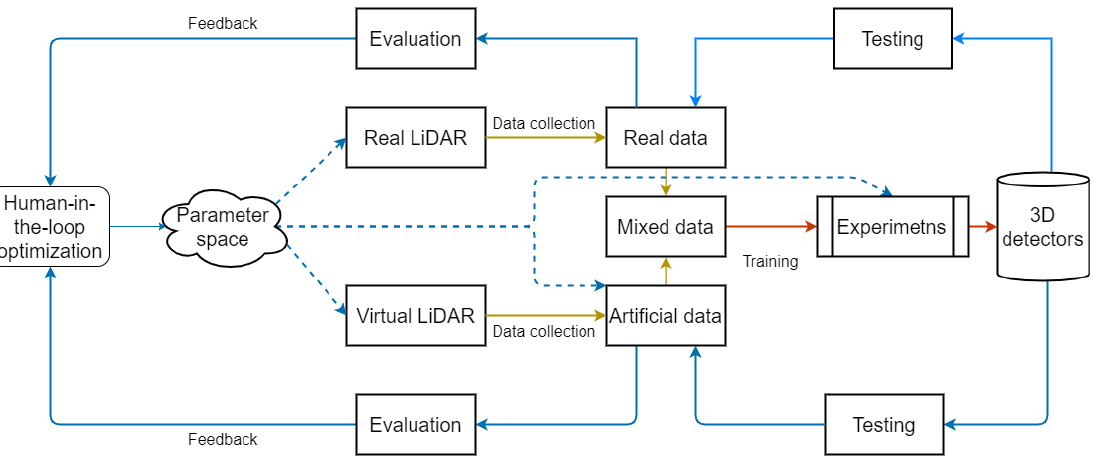
Figure 1. The framework of the parallel point clouds.